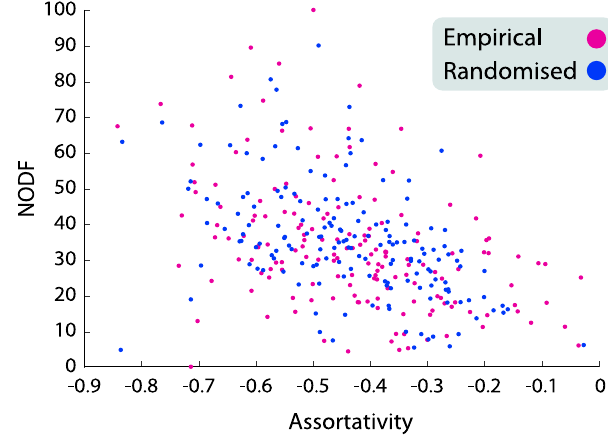
FIG. 12. Relation between the degree assortativity and the nestedness for the real network (in pink) and the average measure for the randomized case (in